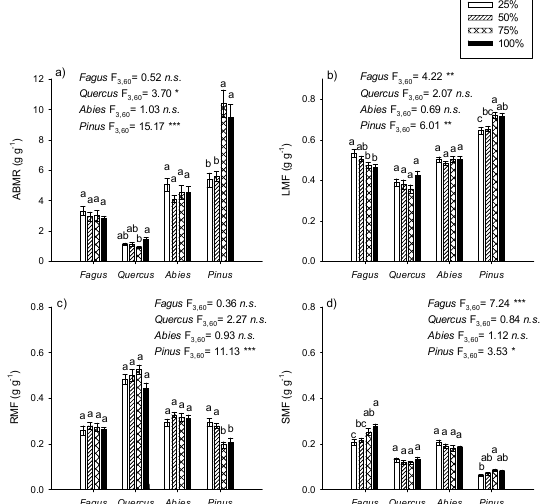
Figure 3. Patterns of biomass allocation in Fagus sylvatica , Quercus petraea , Abies alba , and Pinus sylvestris seedlings grown at di ff erent irrigation treatments (100%, 75%, 50%, and 25% of the recommended dose): aboveground to belowground mass ratio (ABMR; ( a )), leaf mass fraction (LMF; ( b )), root mass fraction (RMF; ( c )) and stem mass fraction (SMF, ( d )). Bars indicate means ± SE ( n = 16). One-way analysis of variance F -values for treatment e ff ect and the associated p values are shown separately for each species (*** p < 0.001, ** p < 0.01, * p < 0.05, n.s.—not significant). Means marked by the same letters (a, b, c) within species were not significantly di ff